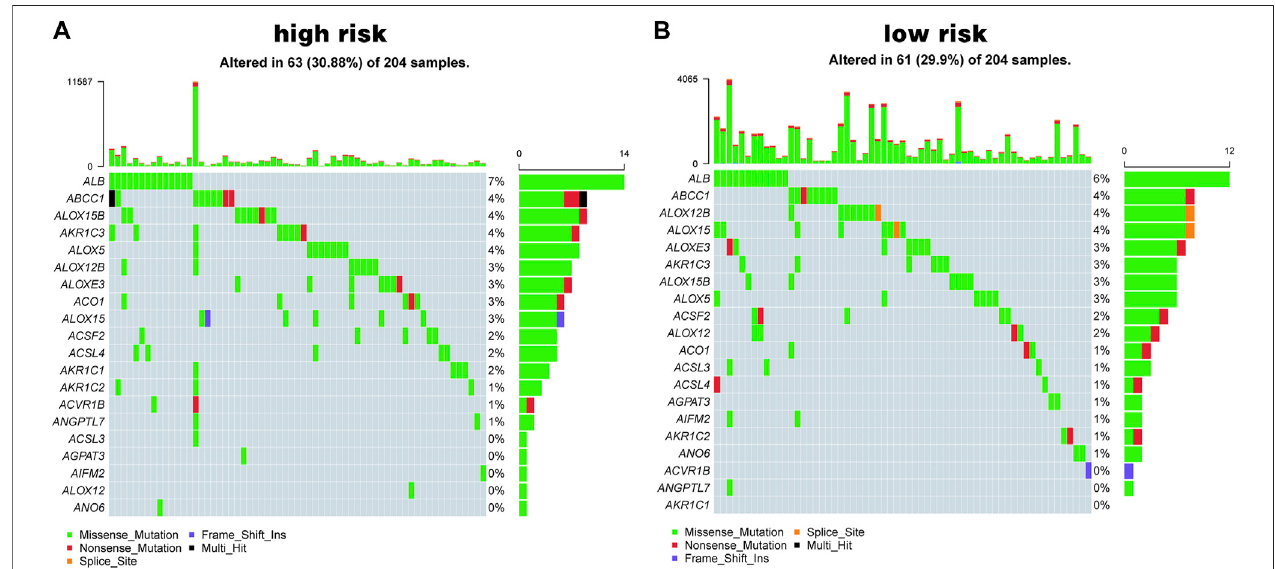
FIGURE 6 | Ferroptosis mutation map. (A, B) The top 20 mutated genes in high-risk group (A) and in low-risk group (B)